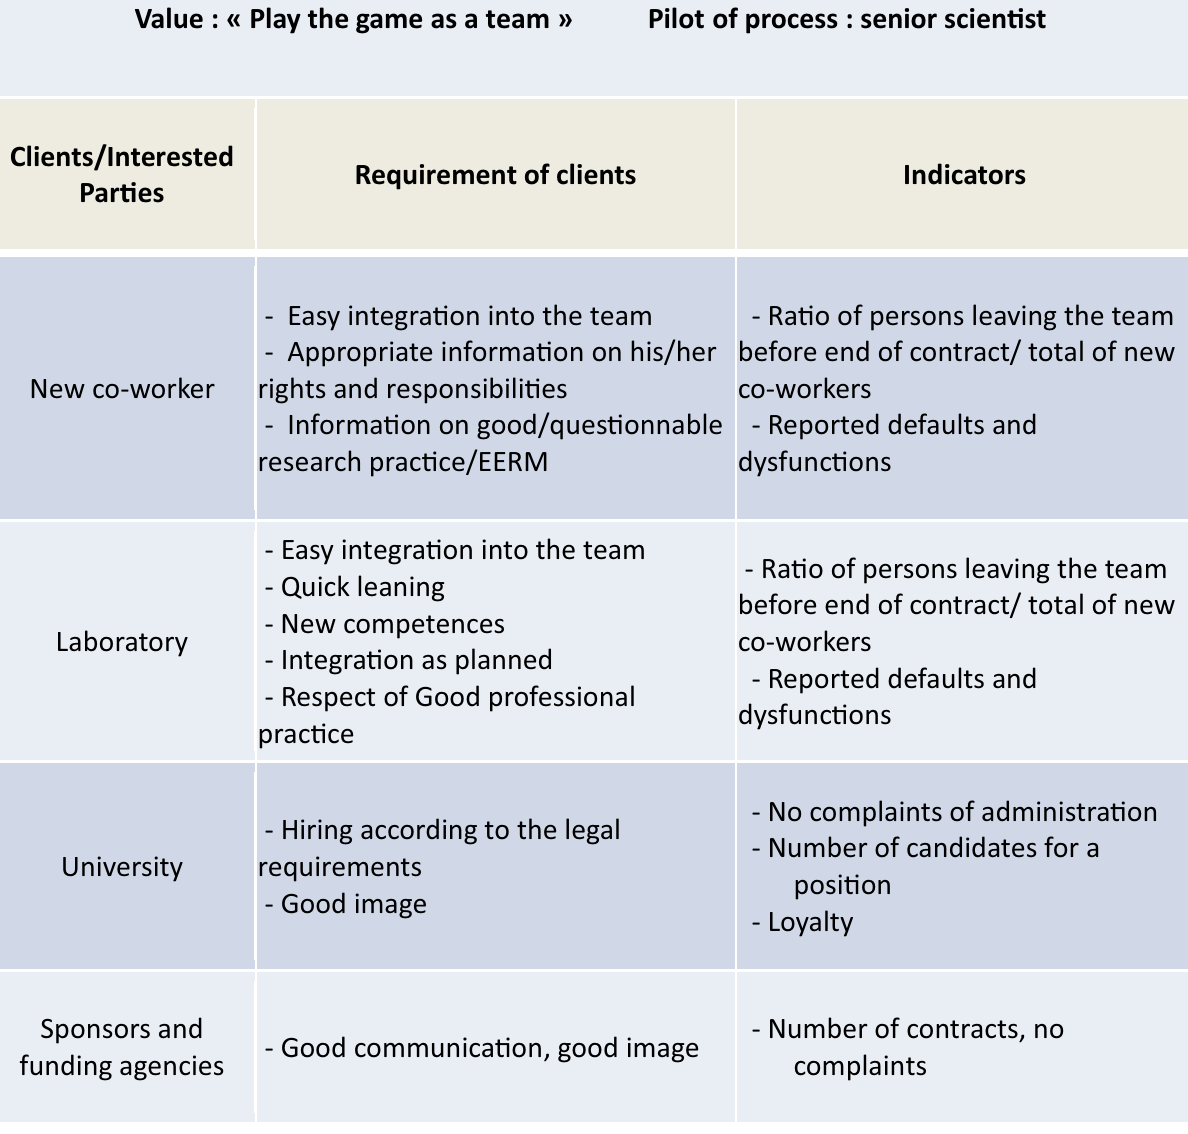
Fig. 1a. ID card of process “ Arrival of a new co-worker ”